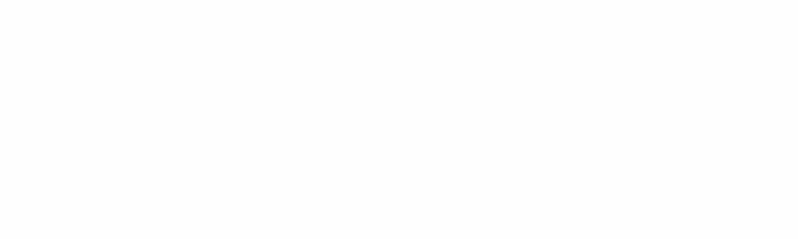
FIGURE 4 The social cycles after the reformers become